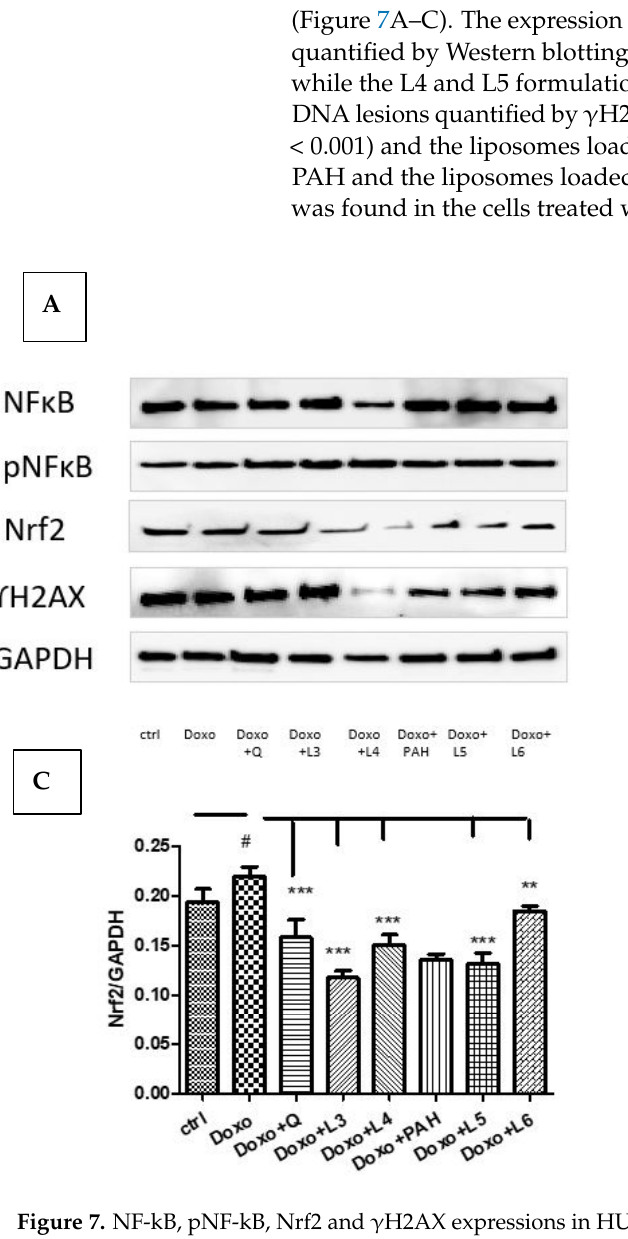
Figure 7. NF-kB, pNF-kB, Nrf2 and γ H2AX expressions in HUVEC lysates after exposure to Doxo and the treatments with quercetin; the PAH extract and the L3, L4, L5 and L6 formulations. Representative images of immunoblotting for NF-kB, pNF-kB, Nrf2, γH2AX and GAPDH in the HUVECs treated with quercetin, the PAH extract and liposomes loaded with quercetin and the PAH extract are shown in the upper panel ( A ), and the results of the statistical analysis for the ratio of Nrf2, γH2AX and GAPDH expressions are in the lower panels ( C , D ). For NF-kB and pNF-kB, the results were expressed as pNF-kB divided by the total NF-kB ( B ). The statistical significance of the differences between treated and control groups was evaluated with one-way ANOVA, followed by Dunnett’s multiple range test; # p < 0.05; ## p < 0.01 vs. control cells and * p < 0.05; ** p < 0.01; *** p < 0.001 vs. Doxo-treated